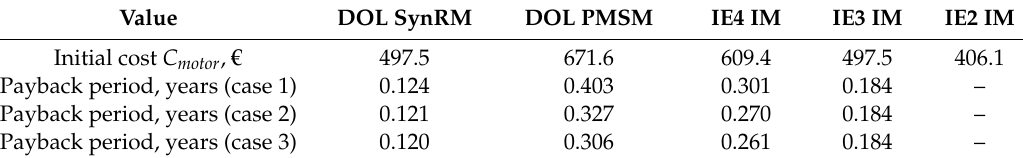
Table 10. Results of the payback period (the case of a new pump unit commissioning).